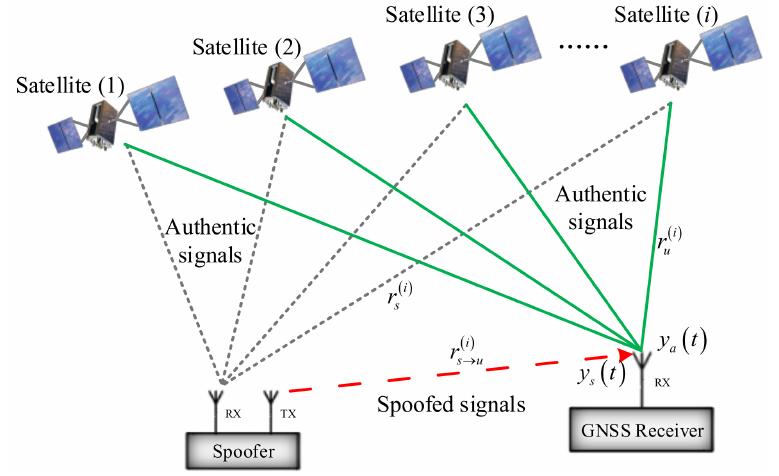
Figure 1. Global Navigation Satellite System (GNSS) spoofing attack